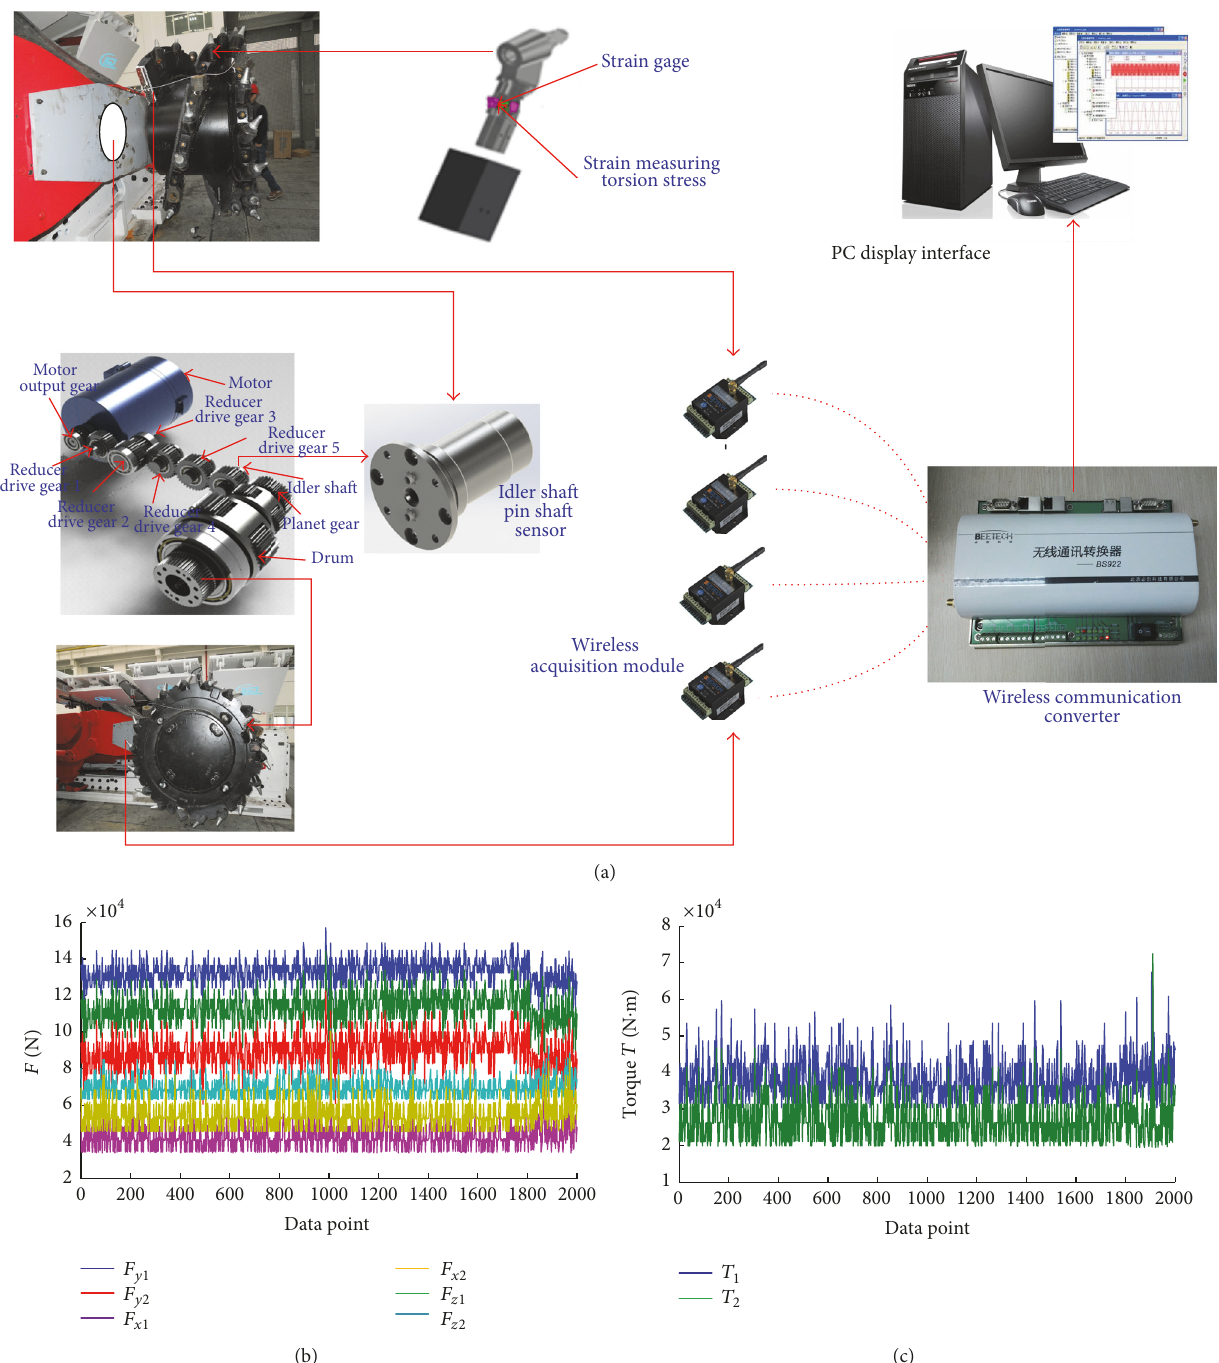
Figure 2: Test system and test load. (a) System layout for evaluating three-direction resistance of cutting picks and corresponding drum torque. (b) Result for three-direction resistance load of cutting picks. (c) Result for drum torque